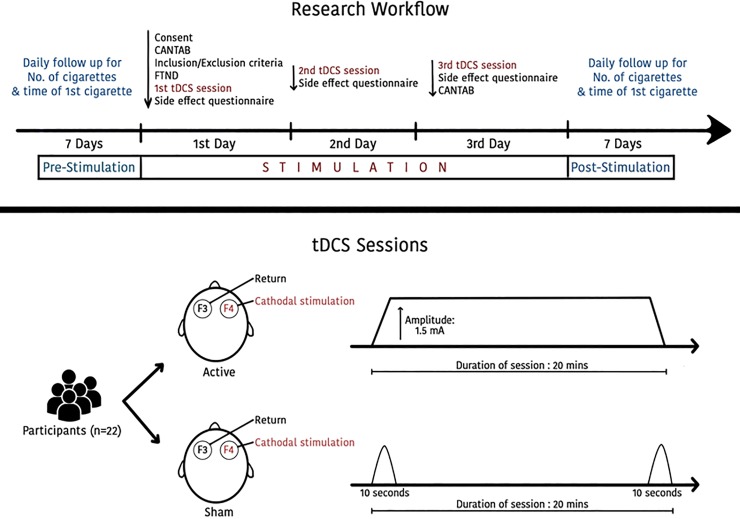
Flow sheet of experimental diagram.